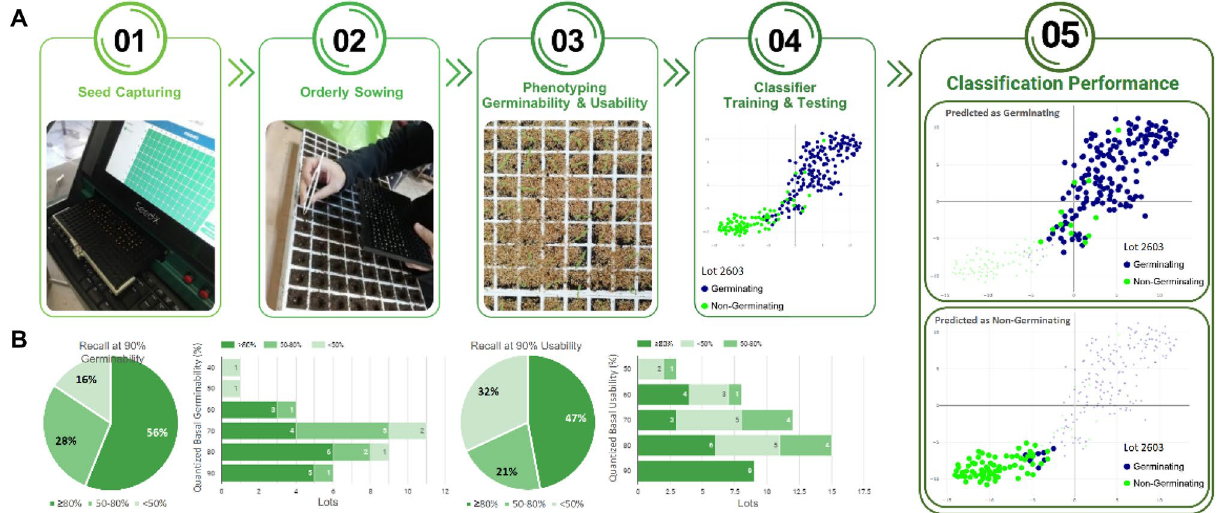
Figure 1. Germinability and usability prediction scheme and results. ( A ) The experimental process consisted of five steps: (1.) Seed-by-seed capturing of lot samples by GeNee Detect, (2.) orderly sowing, (3.) germinability and usability phenotyping, (4.) classifier training with 90% of the image and phenotypic data and classifier testing with the 10% left-out data, and (5) determining classification performance via the percentile bootstrap method and extraction of the average precision, recall at 90% precision and precision at 80% recall measures. The scatter plots at 4. and 5. visualize lot 2603 germinability prediction outputs. A scatter plot is a 2D projection of the multi-dimensional seed variation assigned by the classifier. Each dot represents a single seed and the closer the dots are, the more similar the seeds are. Here, dot colors represent actual phenotypes. At 4., seed dispersal resulted in an apparent, although incomplete, spatial separation between the blue germinating and green non-germinating test set seeds. At 5., setting a 90% precision ratio (upper plot, bold seeds predicted as germinating) resulted in a corresponding 98% recall, with 2% of the germinating seeds mistakenly associated with the seeds predicted as non-germinating (lower plot, bold seeds). ( B ) Pie charts: all 32 germinability and 47 usability predictions achieved 90% precision, but with various recalls. 56% and 47% of the predictions, respectively (51% in total), were ascribed with high (≥ 80%) recall. Bars: high recall was achieved across a broad basal germinability or usability, as low as 59% and 57%, respectively (here both quantized to 60%). Quantized rates (%) encompass ± 5% values. Scatter plots were generated by Plotly.js version 2.5.1: https:// github. com/ plotly/ plotly.